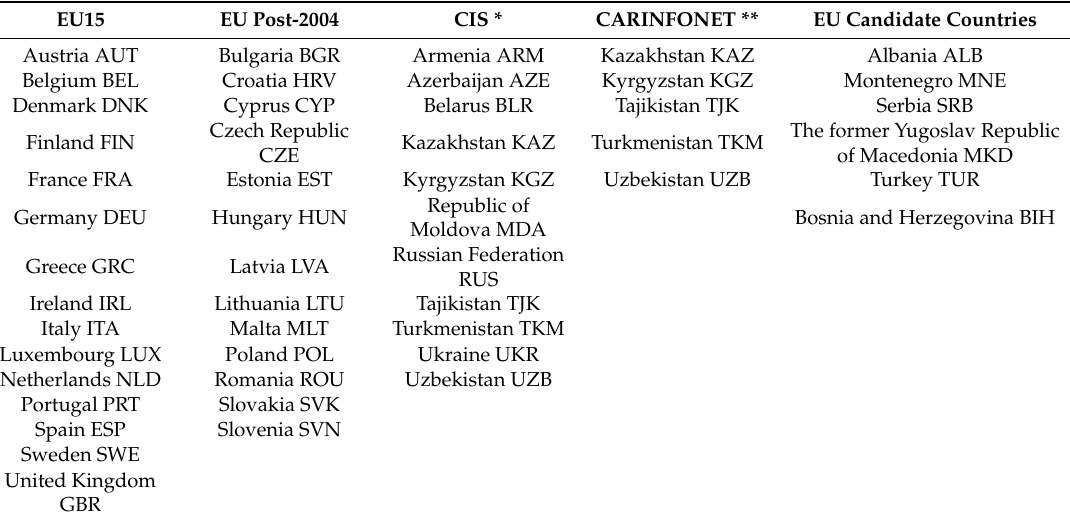
Table 1. List of country groups